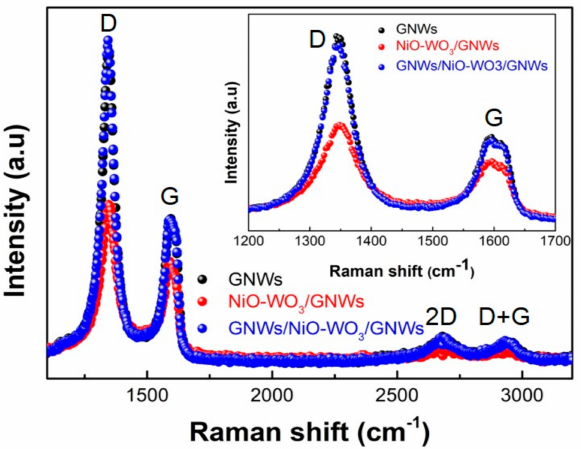
Figure 4. Raman spectra of the GNWs/NiO-WO 3 /GNWs heterostructure with enlarged D and G bands